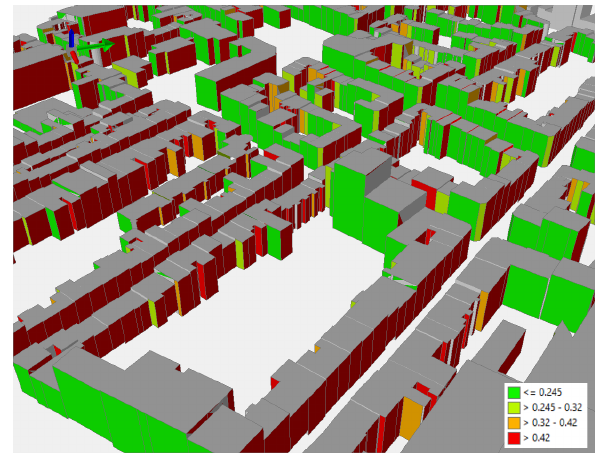
Figure 9. Cost of generated electricity per fac¸ade in [Euro/kWh] for a different point of view (clipping, south-west city area) hyper-point per timestamp. This takes per fac¸ade element sev- eral minutes to process depending on the number of hyper- points per wall. Since parallel processing of the fac¸ade elements is implemented and running on an 80-core dedicated server ma- chine, the completion for an entire city of 3 million generated hyper-points uses a decent amount of time (about 15 days) for the given size of the data set and complexity of